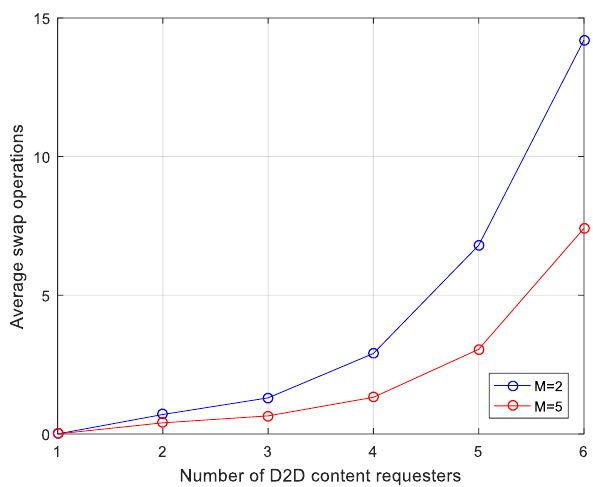
Figure 4. Average swap operations for different numbers of cellular channels with different D2D content requesters.